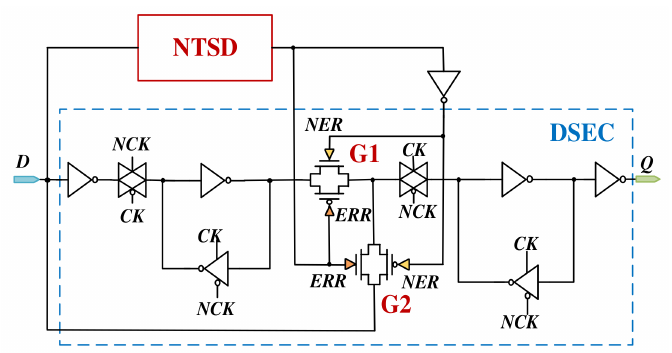
Figure 4. The schematic of the proposed